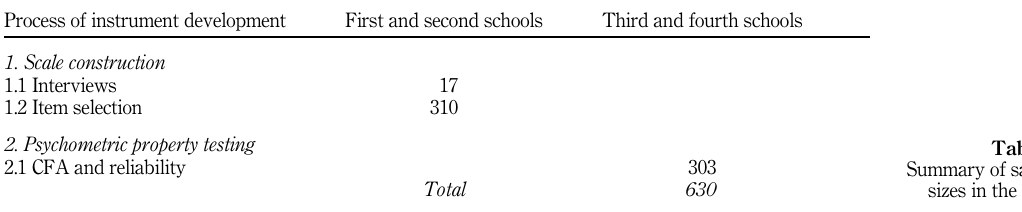
Table 1. Summary of